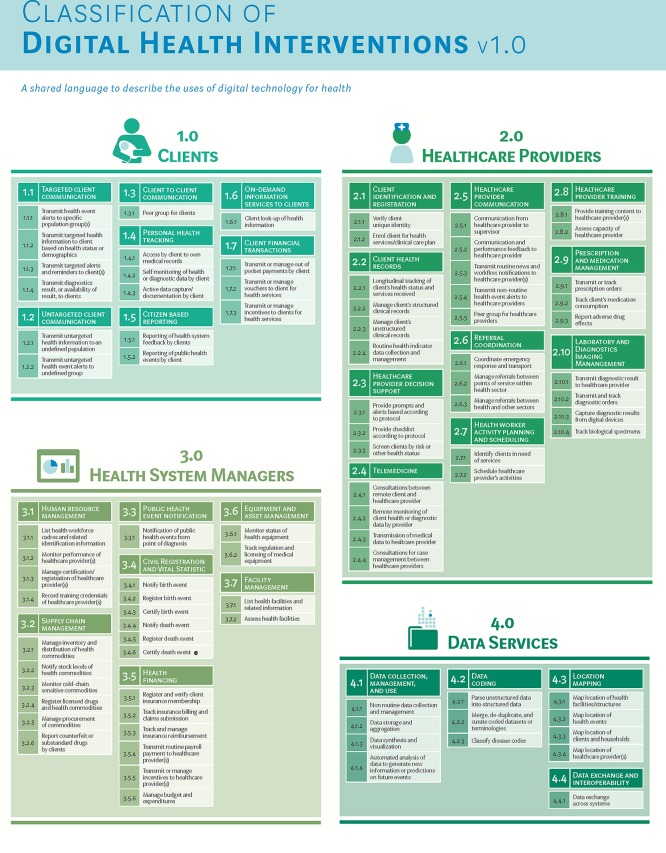
WHO Classification of Digital Health Interventions Released December 2017Source: WHO (2018).27